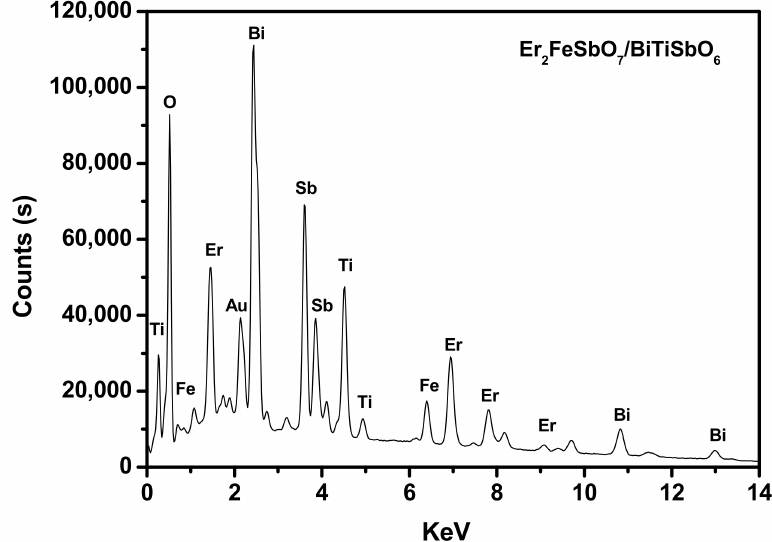
Figure 11. EDS spectrum of